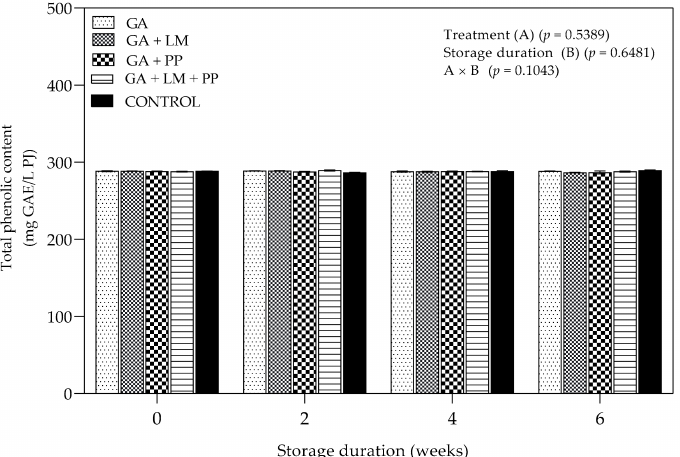
Figure 10. Total phenolic content (mg GAE/L PJ) of ‘Wonderful’ pomegranate whole fruit coated with gum arabic (GA) coatings enriched with lemongrass oil (LM) (0.1% v/v ) and/pomegranate peel extract (PP) (1% w/v ) and stored at 5 ± 1 ◦ C (95 ± 2% RH) for 6 weeks followed by 5 d at shelf-life conditions (20 ± 1 ◦ C and 60% RH). Vertical bars represent the standard error (SE) of mean values calculated from three measurements (Aril juice extracted from 10 fruit = 1 replicate = 1 measurement).